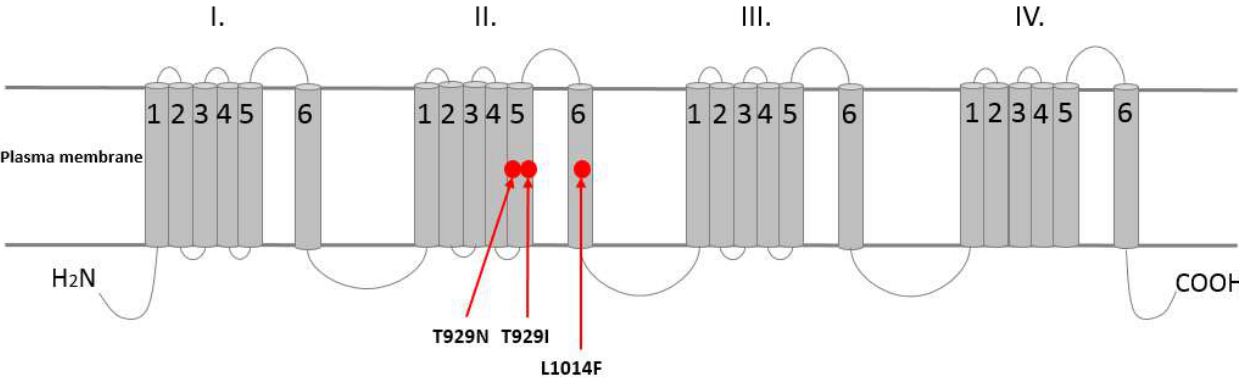
Figure 4. Identified mutations in the voltage-gated sodium channel in Colorado potato beetle populations that are associated with pyrethroid resistance (adapted from Rinkevich et al. [51]). The sodium channel protein contains four homologous repeats ( I – IV ), each part has six transmembrane segments (S1–S6). The red circle mutations were identified in pyrethroid resistant CPB: L1014F, T929I and T929N.